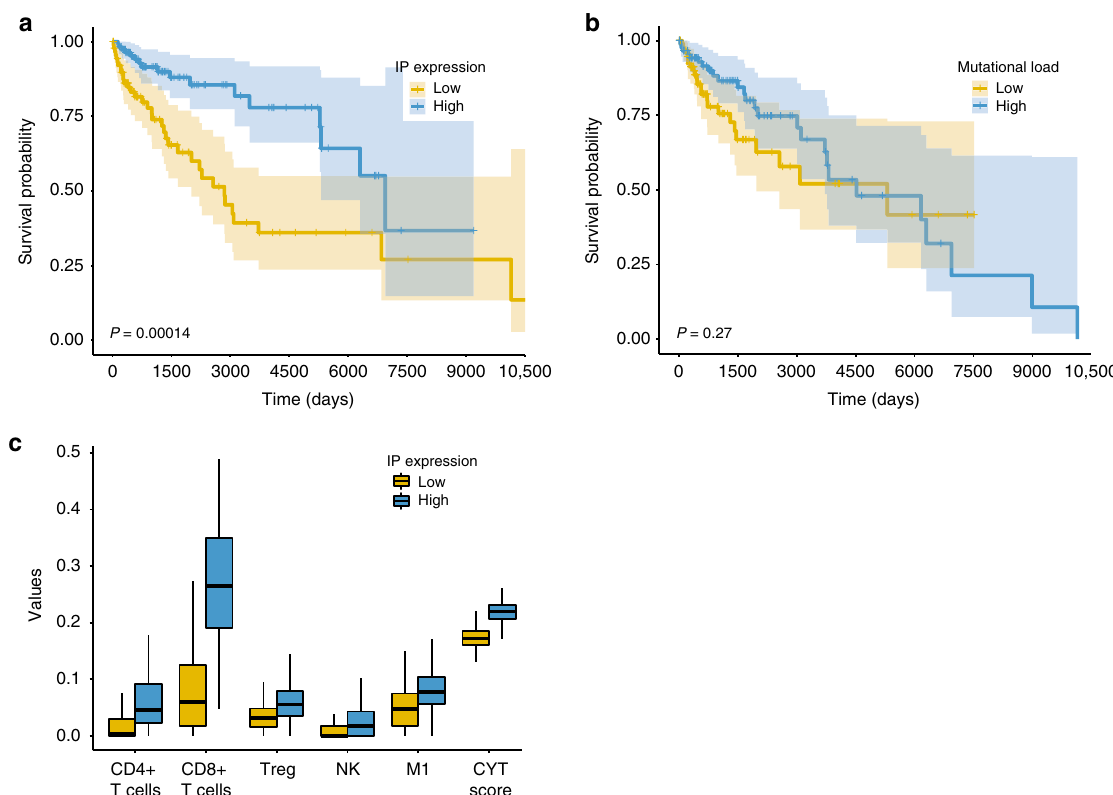
Fig. 1 IP subunits expression is associated with better prognosis. a , b Kaplan – Meier plot of TCGA melanoma patients ( n = 472), where the survival of patients with high ( a ) IP expression, and ( b ) Mutational load (top tertile; blue) is compared with that of the patients with the low counterparts (bottom tertile; yellow) (logrank P = 0.00014 and P = 0.27 with median survival time difference 4094 and 783 days, respectively). c The estimated abundance of CD4 + T-cell, CD8 + T-cell, regulatory T-cell (Treg), NK cell (NK), M1 macrophage (M1), and cytolytic score (CYT score) of patients with high IP subunits expression (top tertile; blue) are higher compared to patients with low IP subunits expression (bottom tertile; yellow) (FDR-corrected Wilcoxon ranksum P < 0.05). Table 1 Comparative Cox regression analysis of IFN γ , T-cell in fi ltration, and IP expression in TCGA melanoma